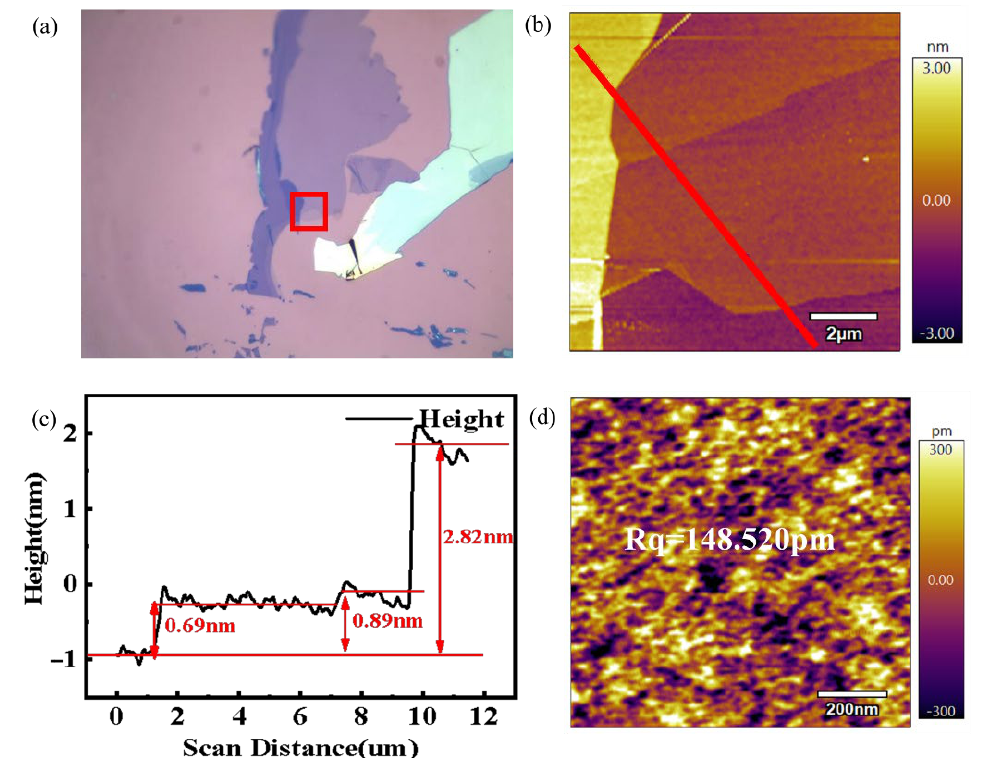
Figure 1. Graphene nanosheets of different thicknesses. ( a ) Optical microscopy, ( b ) AFM morphology, ( c ) height of the corresponding transect in the morphology, ( d ) 0.69 nm microstructure and roughness of graphene with different thickness. The red line in ( a ) represents the actual position of the topography, and the red line in ( b ) represents the corresponding cross − section of the height map.